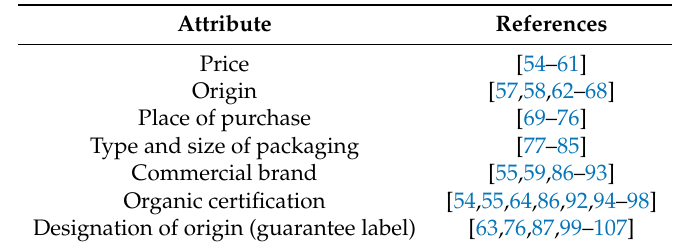
Table 2. Extrinsic attributes considered in some food research